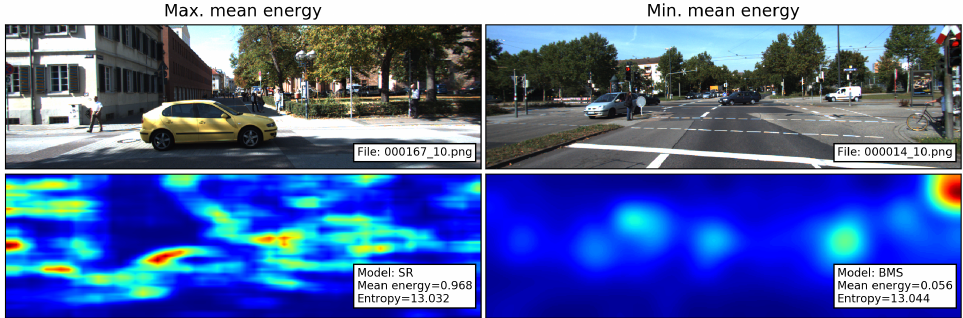
Figure 2. Images and their corresponding saliency maps with the maximum and minimum mean energy. SR produces several salient regions with complex shapes. In contrast, BMS produces blob-like salient